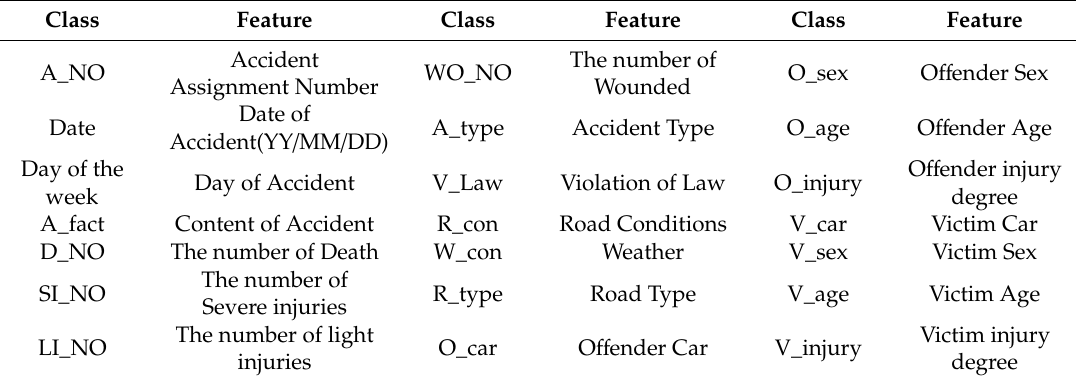
Table 1. Crawled Tra ffi c Accident Analysis System (TAAS) data.